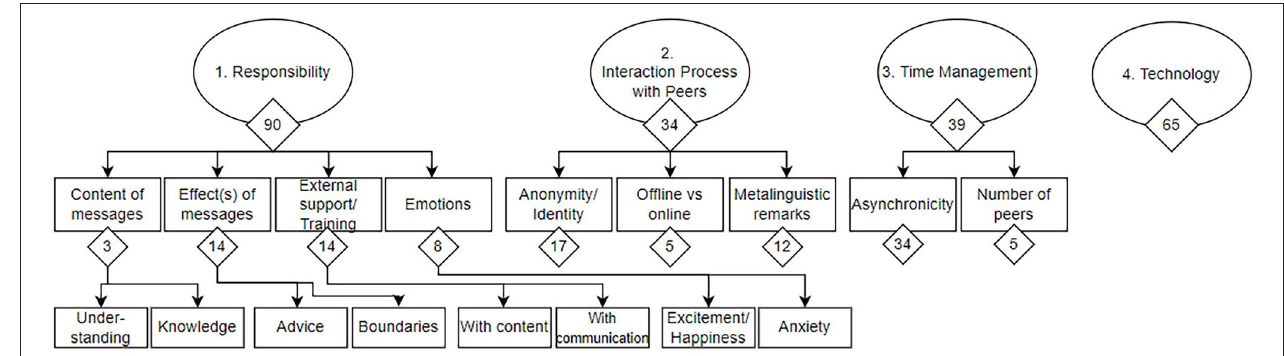
FIGURE 1 | Coding tree of themes and subthemes. The number of coded sequences per theme can be found below each